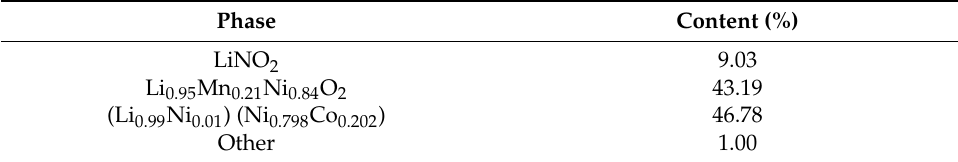
Table 2. Analysis results of waste NMC-811 leaching solution.